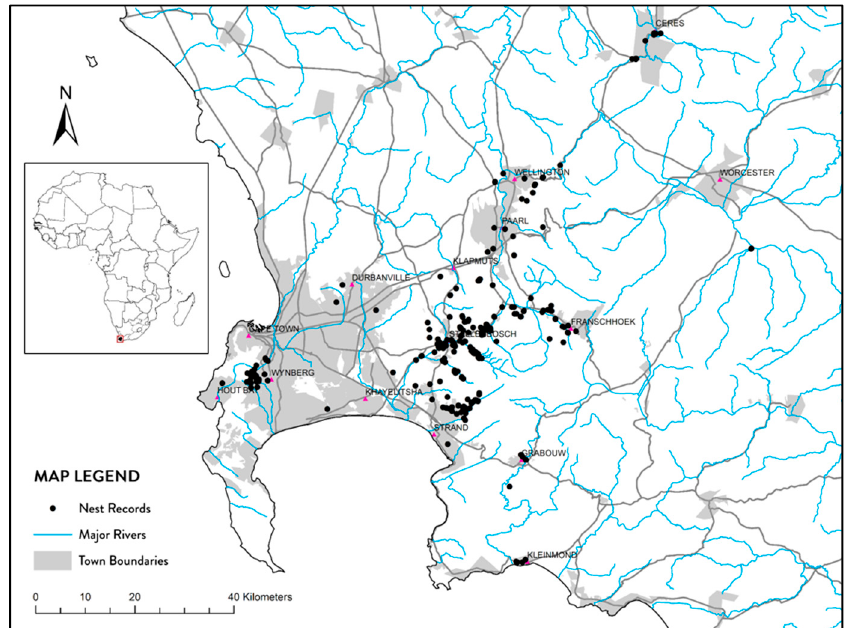
Figure 1. Map showing the distribution of V. germanica nest records in the Western Cape relative to indicators of human activity (i.e., town municipal areas and major road networks) and major river courses. Table 1. Value ranges of environmental variables measured for V. germanica nests (median, standard percentiles, and 80% of nest records centred on the median) measured for standard median and quantiles plus additional 10th and 90th percentiles. CV is the coefficient of variation (mean divided by the standard deviation multiplied by 100 to yield a percentage).